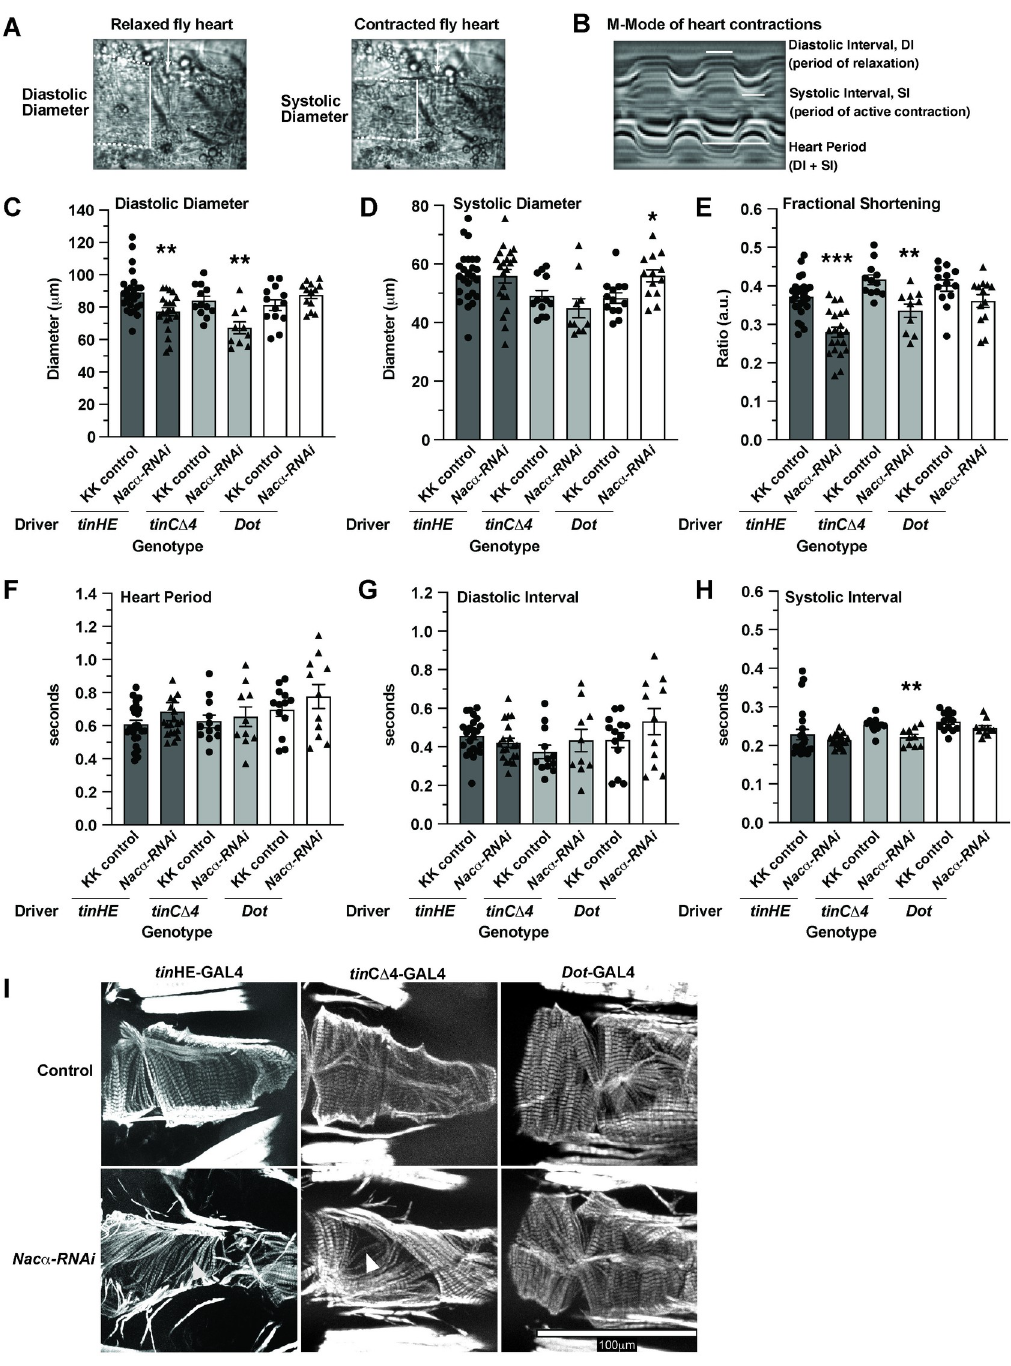
Fig 2. Effect of Nac α knockdown (KD) using various GAL4 drivers on heart function and structure. A , B Structural and functional parameters measured by SOHA to assess the fly heart. Dotted lines indicate the heart tube borders. White solid vertical lines indicate the diameters of the heart, while horizontal lines indicate the duration of contraction/relaxation being measured. A, Diastolic Diameter measures the heart diameter when it is fully relaxed, while systolic diameter measures the heart diameter when it is fully contracted. B , Motion-mode (m-mode) of the heart for temporal resolution of heart movement. Diastolic Interval measures the duration during which the heart is non-contractile, which occurs in this denervated fly preparation. Systolic Interval measures the duration that the heart is in active contraction and relaxation. C , Both tinHE -GAL4 and tinC Δ 4 -GAL4 cardiac drivers reduced Diastolic Diameter when used to KD Nac α expression (KK v109114). Dot -GAL4 pericardial cell driver had no effect on diastolic diameter. D, Cardiac drivers had no significant effect on systolic